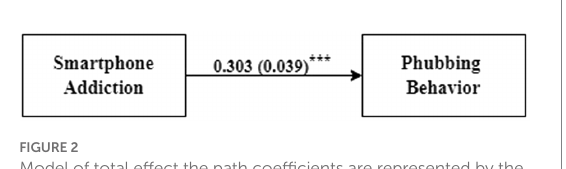
FIGURE 2 Model of total effect the path coefficients are represented by the path values (standard errors). *** Value of p < 0.001.